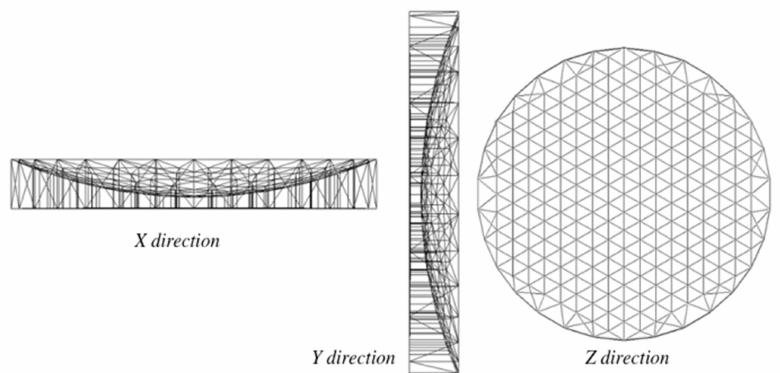
Table 1. Material parameters of the structure.